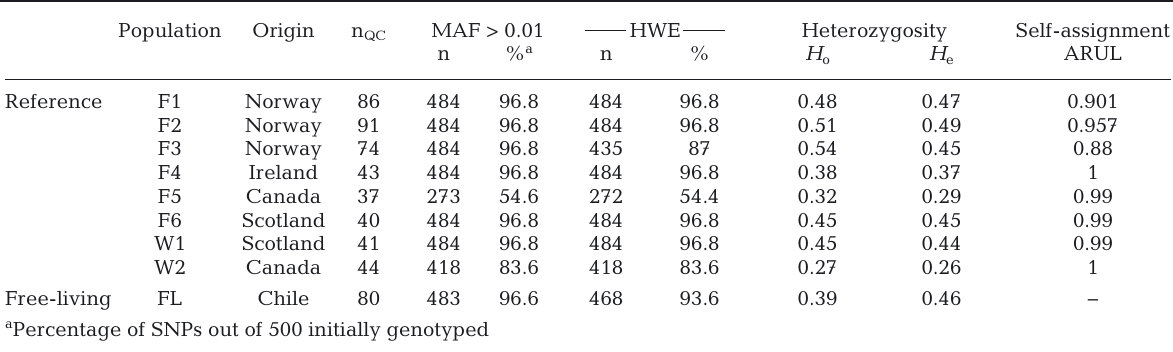
Table 3. Genetic summary statistics of quality control (QC) for reference and free-living collections of Atlantic salmon. n QC : number of samples that passed QC. MAF > 0.01: single nucleotide polymorphisms (SNPs) with minor allele frequency (MAF)